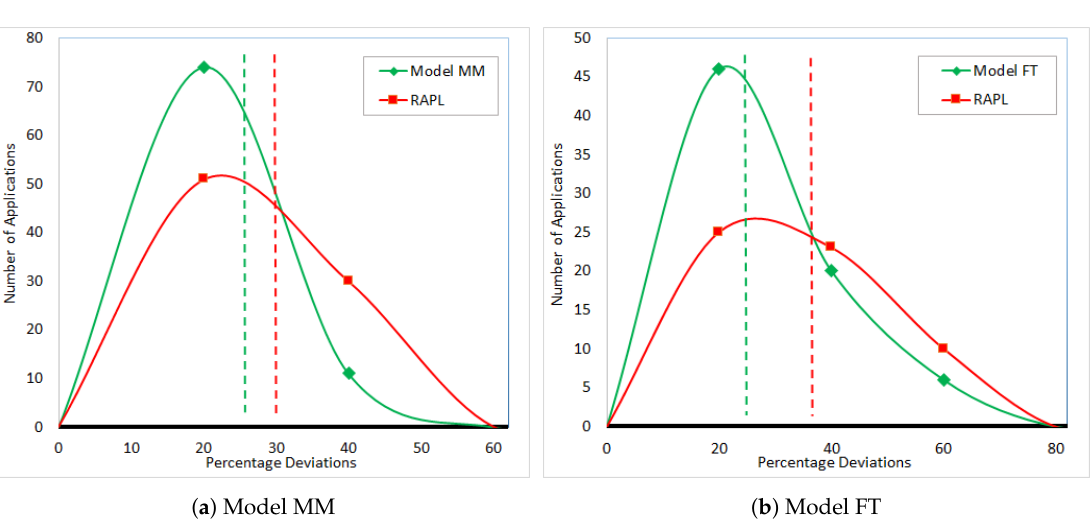
Figure 7. Percentage deviations of predictive models and RAPL from HCLWattsUp. The dotted lines represent the